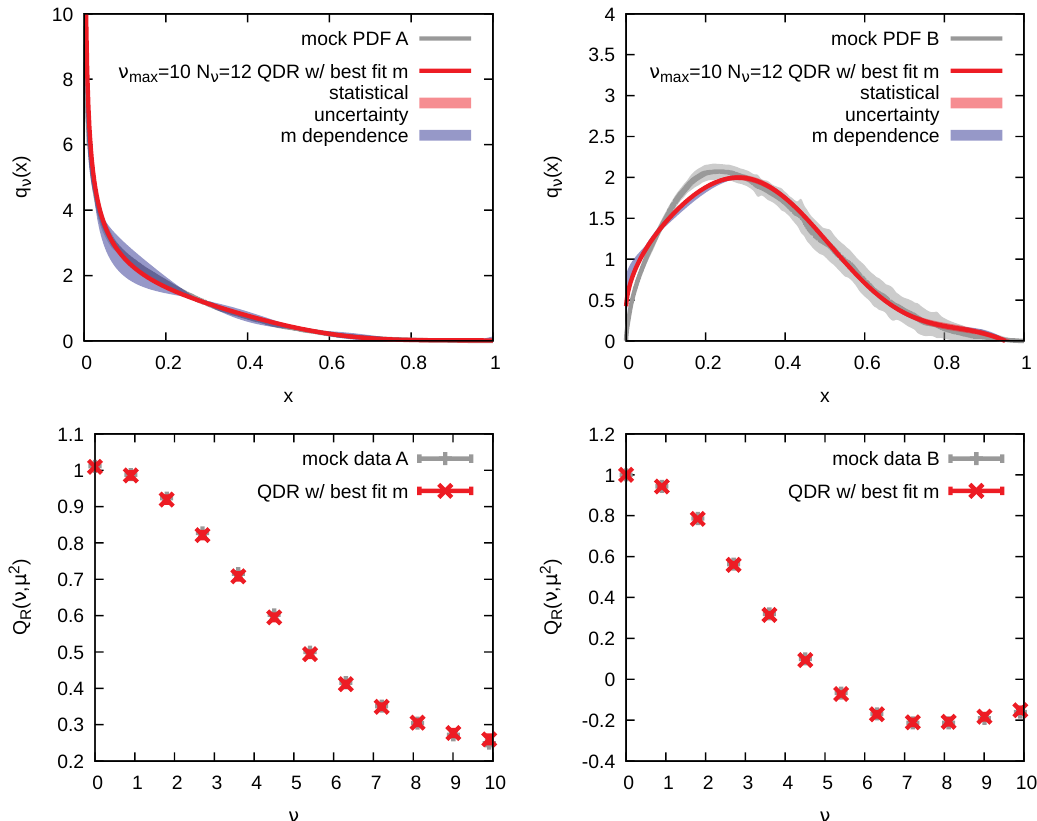
Figure 17 . x -space PDF’s reconstructed using a quadratic prior Bayesian (QDR) method from N (cid:23) = 12 Io(cid:11)e-time data points on the interval (cid:23) = [0 ; 10] (top) as well as the input data (gray crosses) compared to the data arising from the reconstructed PDF (red crosses) in the bottom panels.